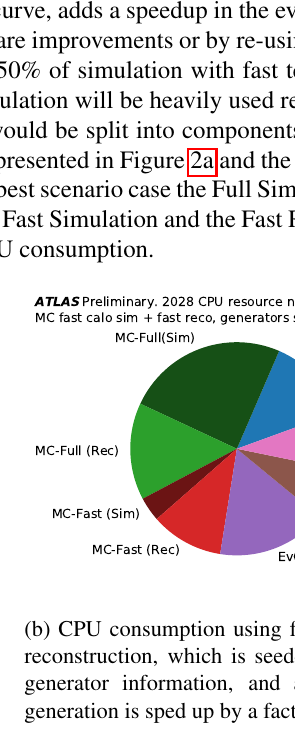
Figure 2: Fraction of CPU resources needed in 2028 at the end of Run 4 for di ff erent process- ing workflows. The “MC-Full” section in green is related to the fraction of time spent on the full AtlasG4 simulation and divided in a simulation part “(Sim)” for the G eant 4 simulation and a reconstruction part “(Rec)” accounting for the time spent reconstructing the events. Similarly, the “MC-Fast” section in red shows this distribution for the time spent running the FastCaloSim simulation